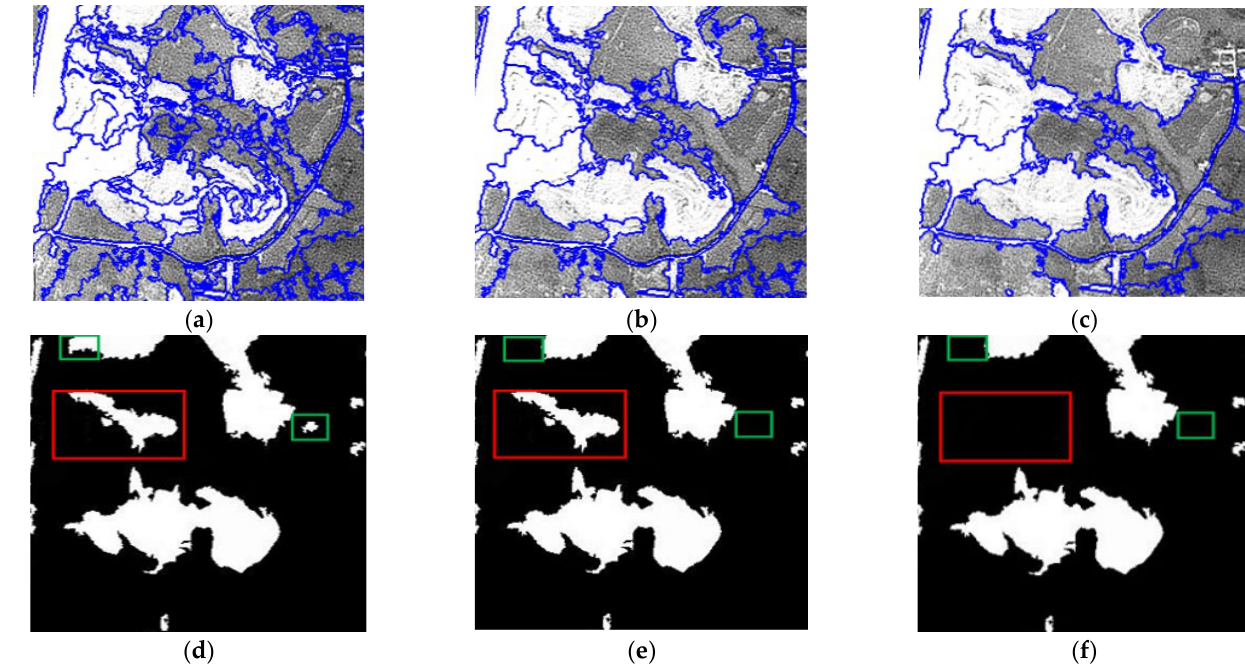
Figure 7. Comparison of recognition results at different segmentation scales: ( a ) image segmentation when scale = 58; ( b ) image segmentation when scale = 87; ( c ) image segmentation when scale = 124; ( d ) changed objects recognition when scale = 58; ( e ) changed objects recognition when scale = 87; and ( f ) changed objects recognition when scale = 124. Green box: false detection; Red box: missed detection.